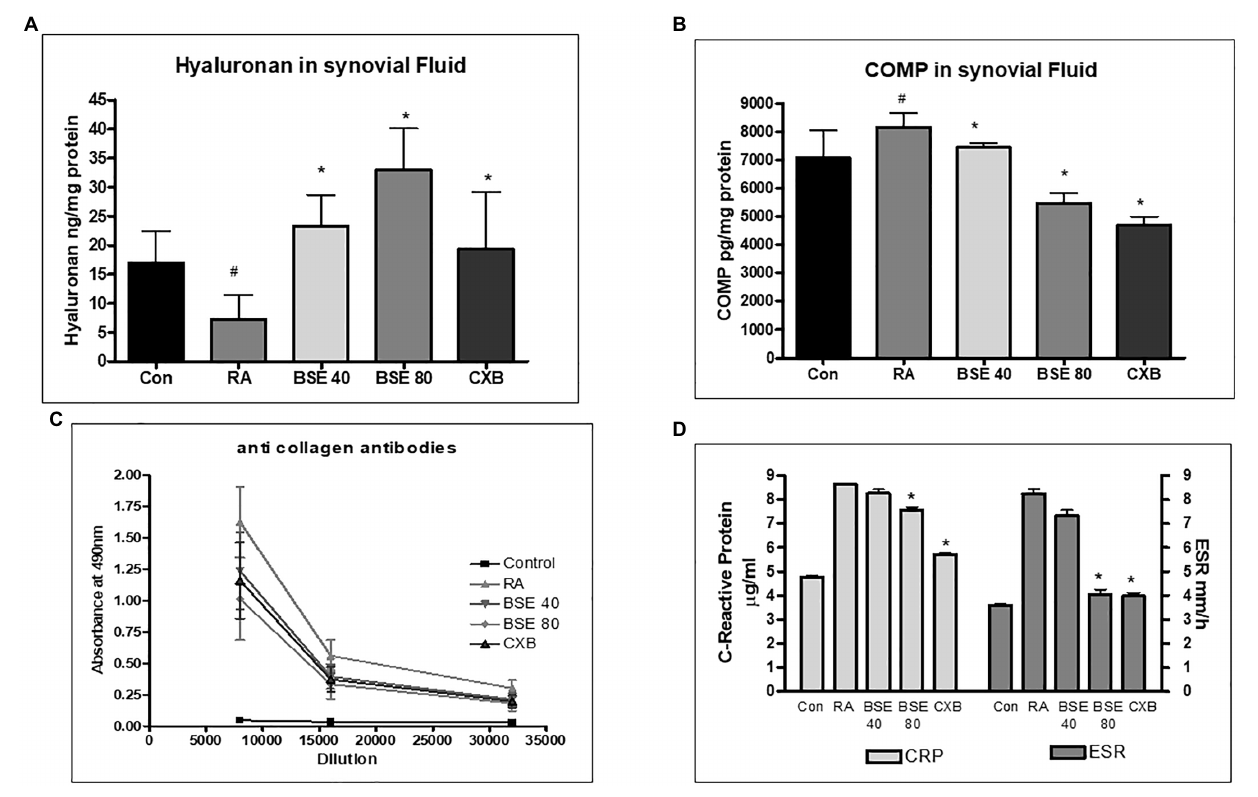
FIGURE 8 | Effect of BSE on (A) hyaluronan in synovial fluid and (B) cartilage oligomeric matrix protein (COMP) in synovial fluid, (C) collagen antibodies in serum, and (D) serum C-reactive protein (CRP) and erythrocyte sedimentation rate (ESR) levels in collagen-induced arthritis in rats. # p < 0.05 compared to control; * p < 0.05 compared to RA animal; BSE40 and BSE80, Boswellin ® Super 40 and 80 mg/kg; CXB, celecoxib 10 mg/kg; and RA, rheumatoid